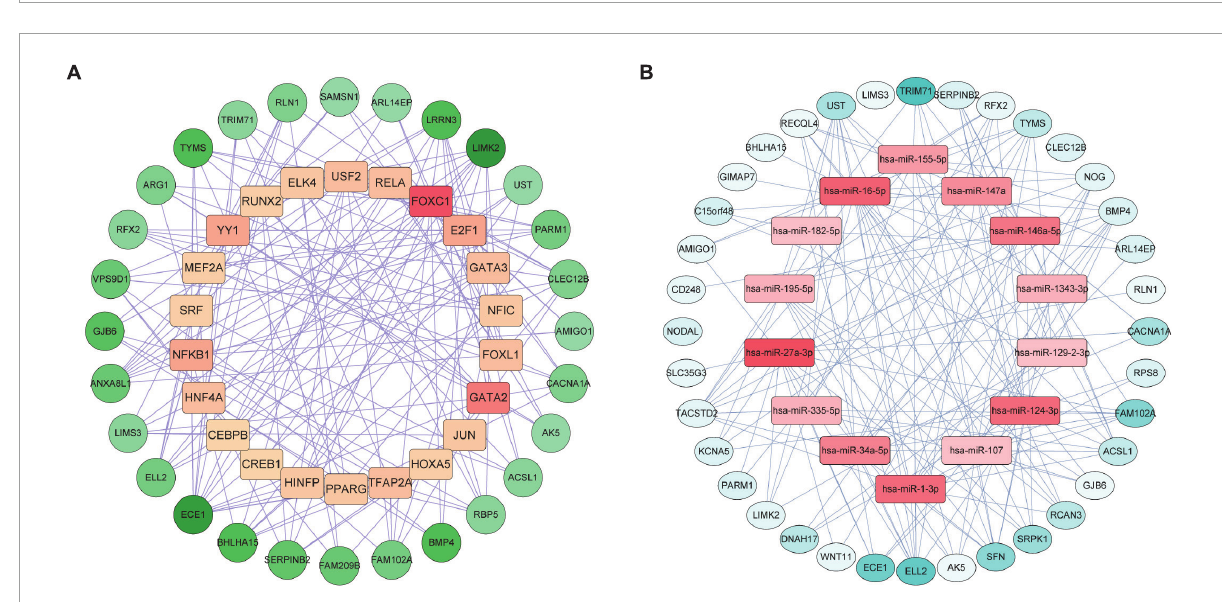
FIGURE6 Gene regulatory network analysis of TF-DEGs (A) and miRNA-DEGs (B) in COVID-19 and AF. The circles represent DEGs and the squares represent TFs or miRNAs. nodes with top50 connectivity are shown, and nodes with high connectivity are presented in darker colors.